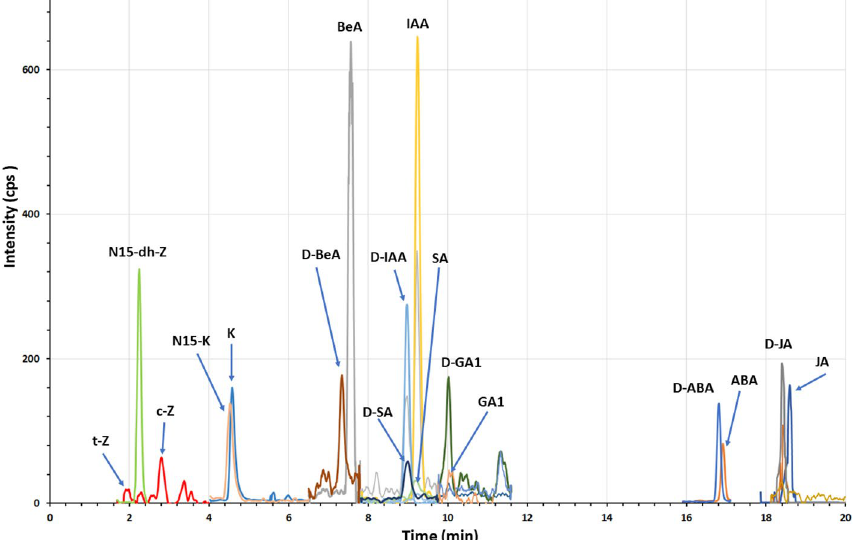
Figure 3. UHPLC-MS/MS chromatogram of multiple reaction monitoring (MRM) transitions for the analysed plant growth regulators (zeatin: Z, kinetin: K, benzoic acid: BeA, indoleacetic acid: IAA, salicylic acid: SA, gibberellin A1: GA 1 , abscisic acid: ABA, and jasmonic acid: JA). Details given in Table